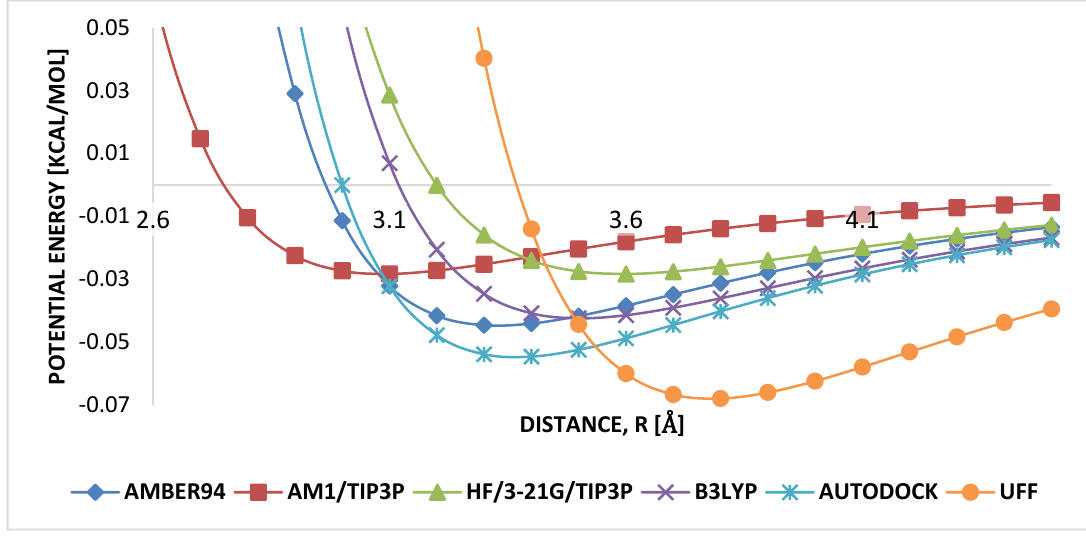
Figure 7. Comparison of LJ parameters carbon–hydrogen.